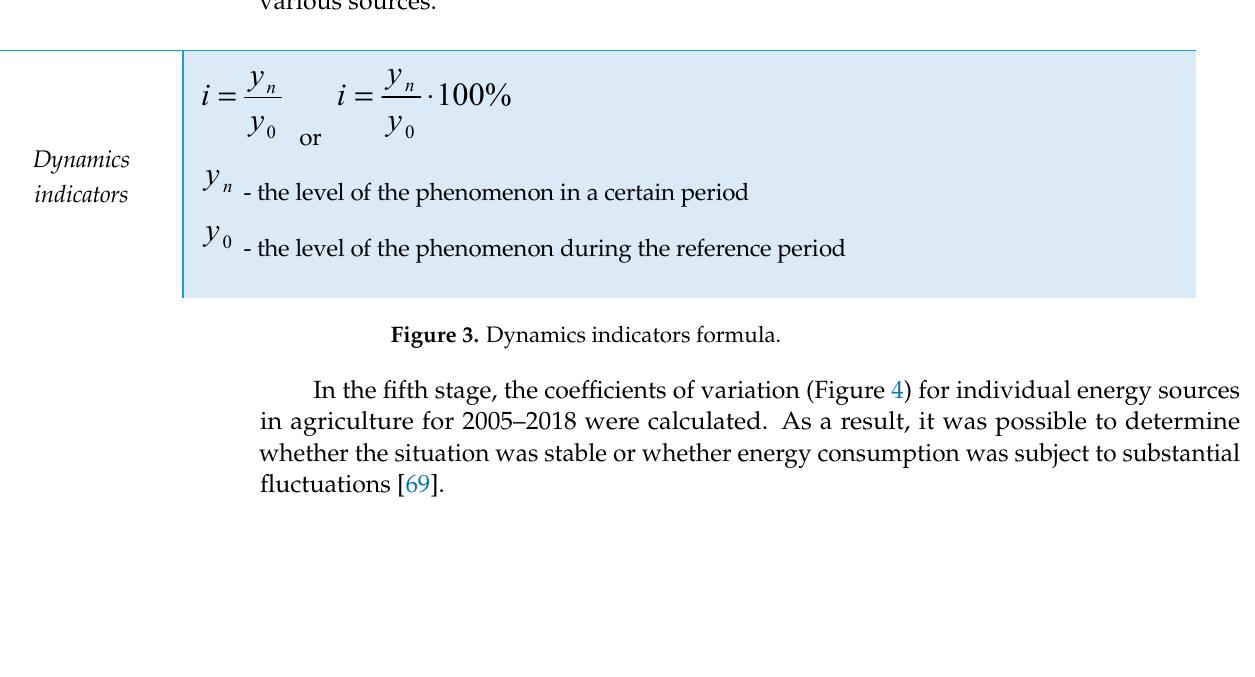
Figure 3 . Dynamics indicators formula .